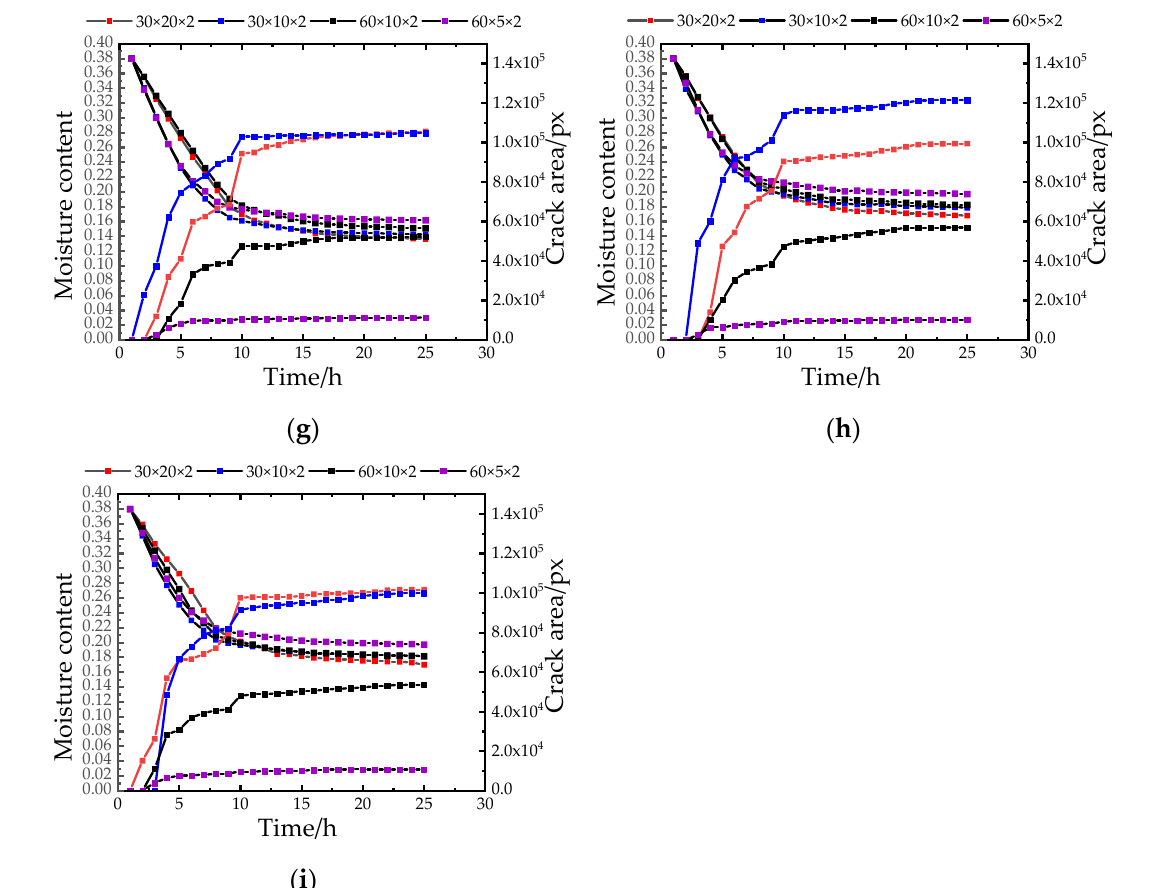
Figure 7. Fracture area curve. ( a ) the change curve of crack area under 21% initial moisture content and 30% humidity; ( b ) the crack area change curve under 21% initial moisture content and 67% humidity; ( c ) the change curve of crack area under 21% initial moisture content and 95% humidity; ( d ) the crack area change curve under 30% initial moisture content and 30% humidity; ( e ) the crack area change curve under 30% initial moisture content and 67% humidity; ( f ) the change curve of crack area under 30% initial moisture content and 95% humidity; ( g ) the variation curve of crack area under 38% initial moisture content and 30% humidity; ( h ) the change curve of crack area under 38% initial moisture content and 67% humidity; ( i ) the change curve of crack area under 38% initial moisture content and 95% humidity.